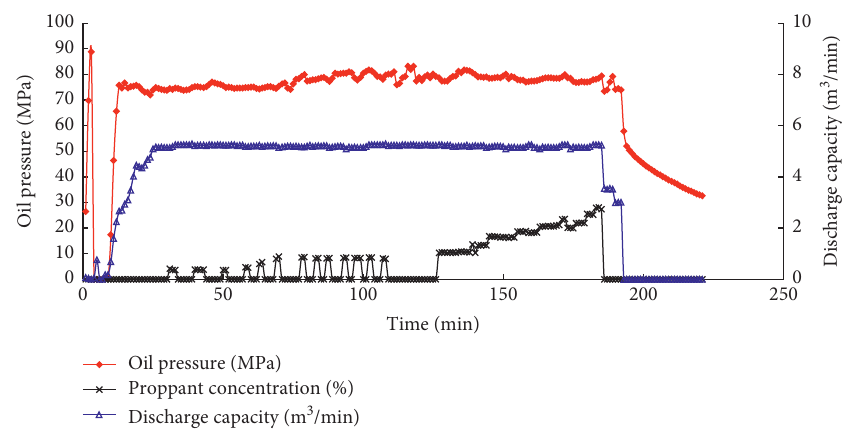
Figure 9: Fracturing construction curve of the NPXX